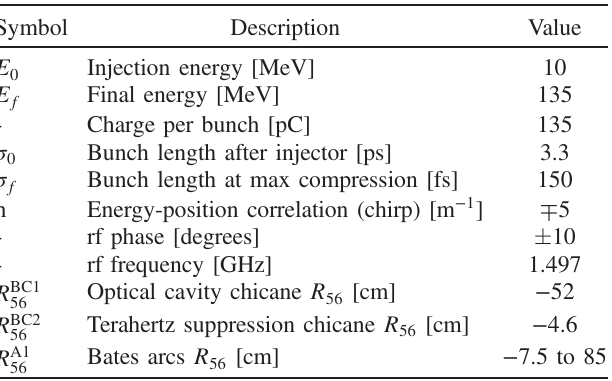
TABLE I. Nominal beam parameters for the experiment and relevant characteristics of the